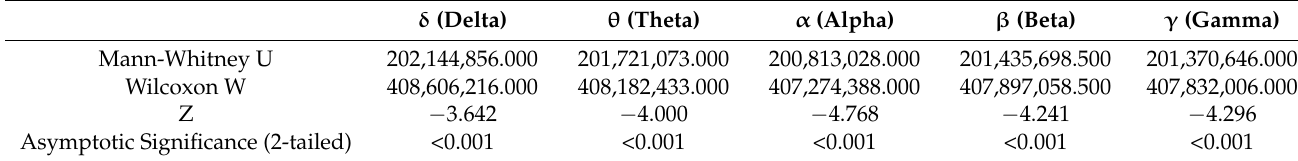
Table A9. Test Statistics for Mann-Whitney U Tests conducted on the Light VDEP.